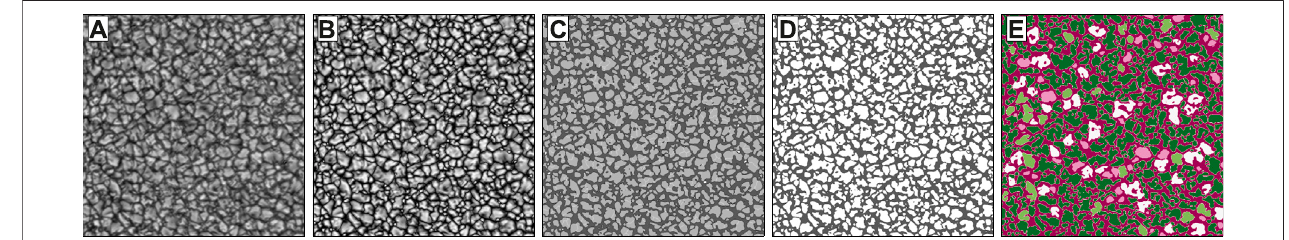
FIGURE 2 | Frame example of IMaX/Sunrise during the labeling procedure. (A) Reconstructed continuum intensity map, (B) Initial segmentation results using 25 descending detection thresholds, (C) Merging and shrinking results, (D) Result map differentiating integranular lanes and granules cells as single units, (E)